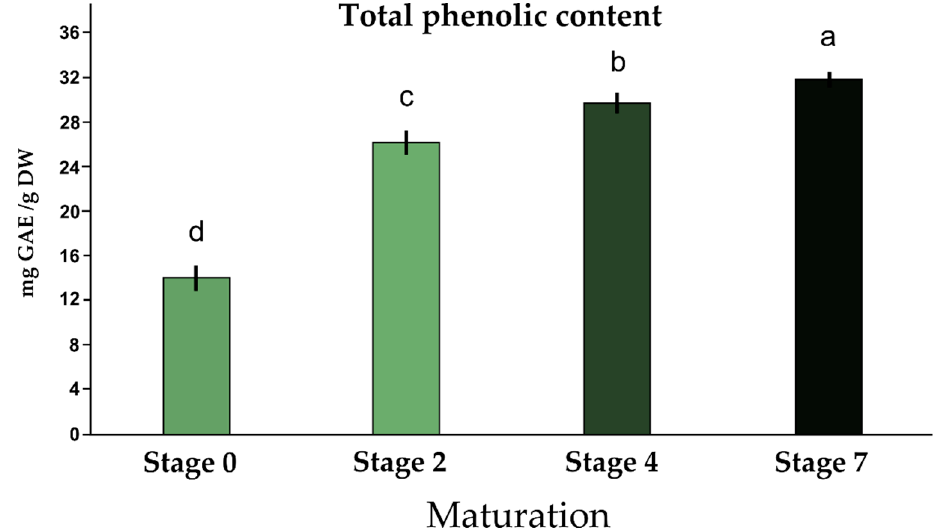
Figure 2. Total phenolic contents (mg GAE/g DW) in Cellina di Nardò olives at four different stages of the maturation process. Results are expressed as mg of GAE/g dried olive pulp. Same letters mean no statistical differences between averages (Duncan test, n = 3, p = 0.05). GAE: gallic acid equivalent; DW: dry weight.